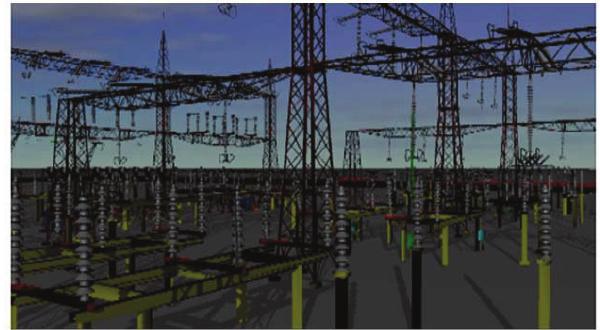
Figure 4. 18 million polygons model visualized in real time.